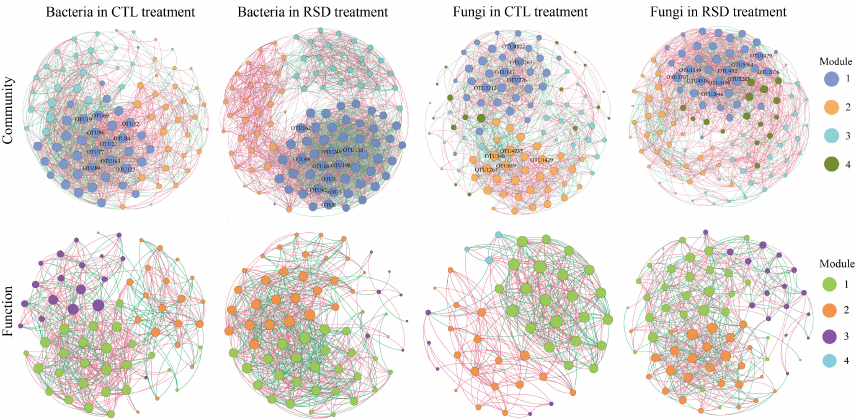
Figure 3. Co-occurrence networks of microbial communities and functions in CTL and RSD soils. The keystone taxa were marked in each network. CTL, untreated soil; RSD, soil incorporated with molasses, irrigated to saturation, and covered with plastic film. Table 1. Topological characteristics of microbial community and function networks in the CTL and RSD soils.